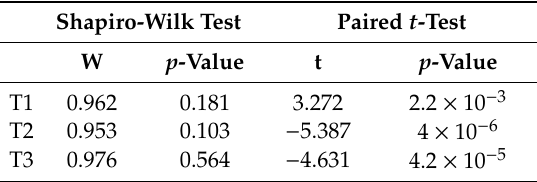
Table 4. Results from the Shapiro-Wilk test performed on the computed error-rate di ff erences, and from the t -test performed on the paired error-rate samples, for each task considered in the in-lab usability